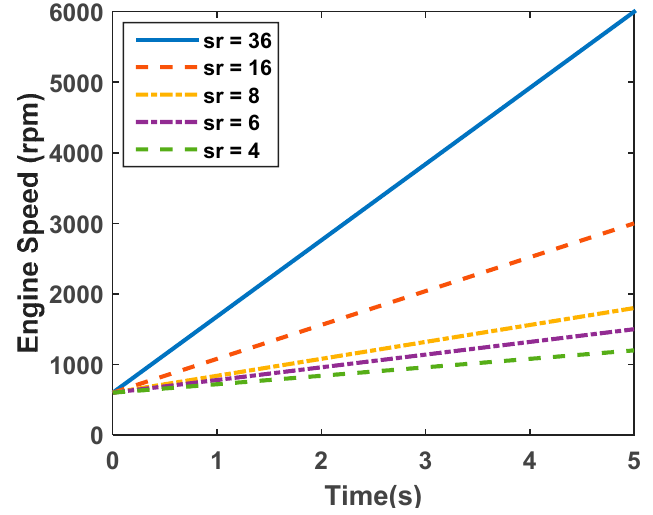
Figure 5. Variation of instantaneous frequency ( f i = rpm/60) of five references.